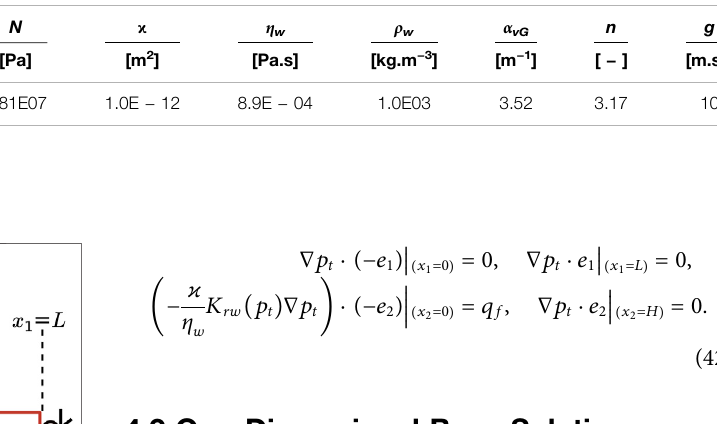
TABLE 1 | Material properties and model parameters used throughout the article unless mentioned otherwise.